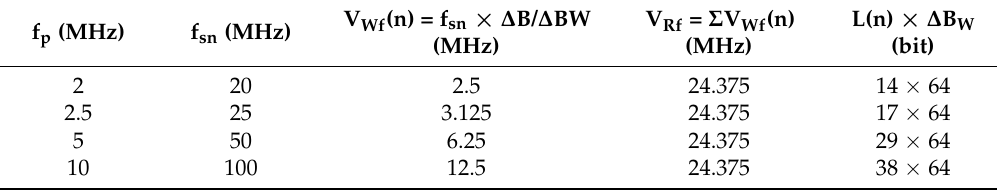
Table 3. The parameters of the 4 groups scanning and the 4 FIFO caches.